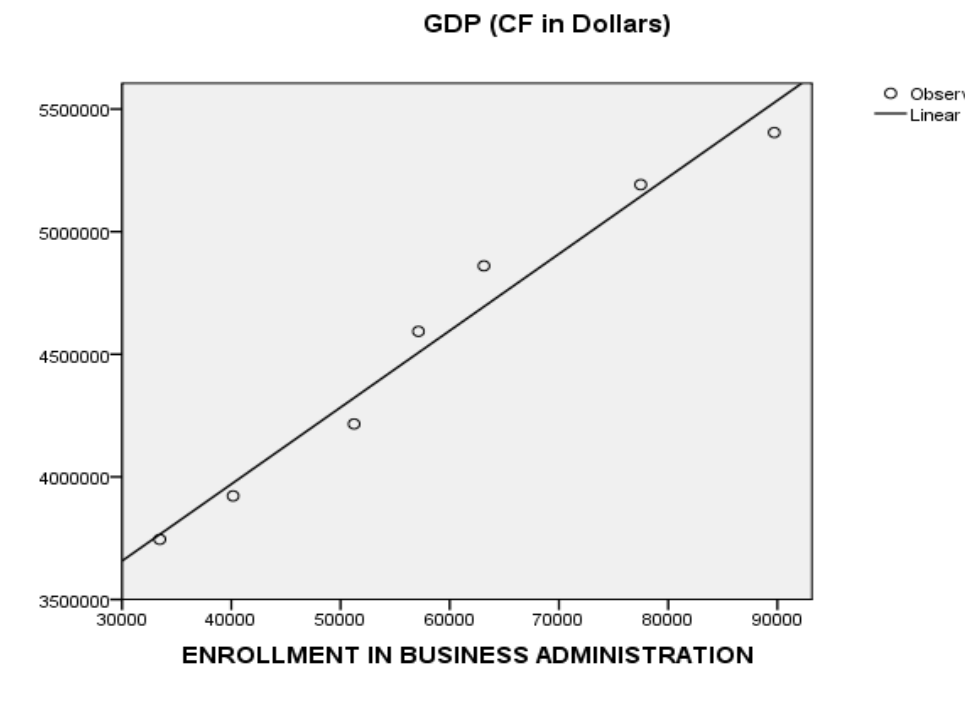
Figure 3: Curve Estimation of GDP and Entrepreneurship